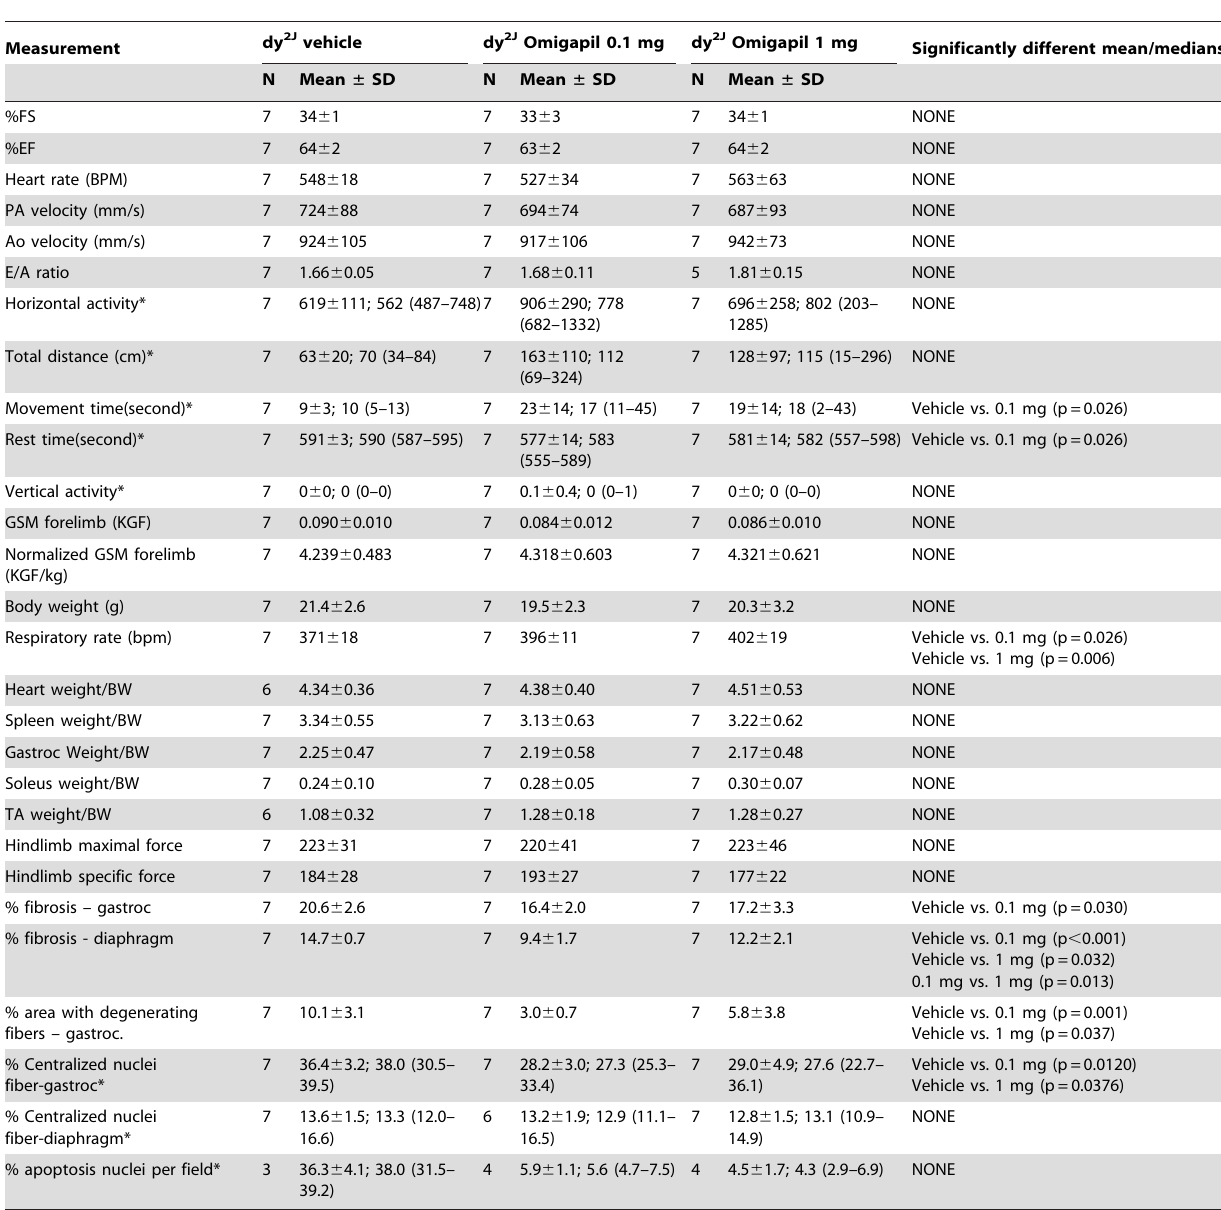
Table 3. Outcome measures for 30–33 week old omigapil and vehicle treated dy 2J mice after 17.5 weeks show